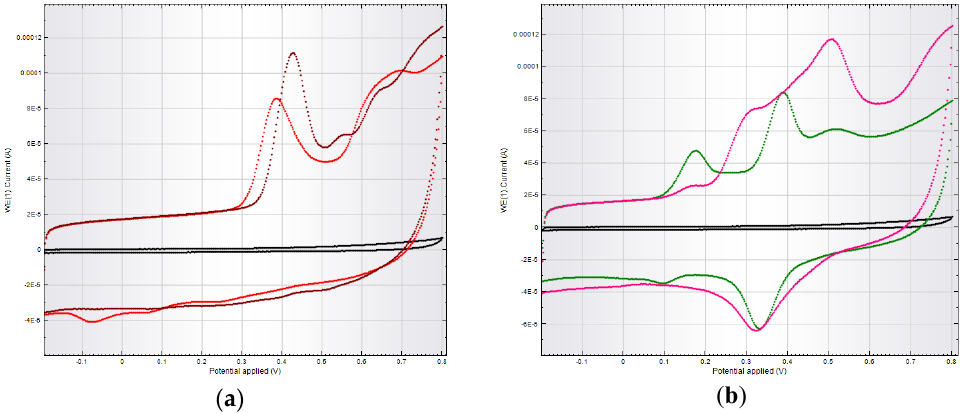
Figure 4. ( a ) Comparison between CVs for 5a (red) and 5b (brown); ( b ) comparison between CVs for 8a (green) and 8b (pink).